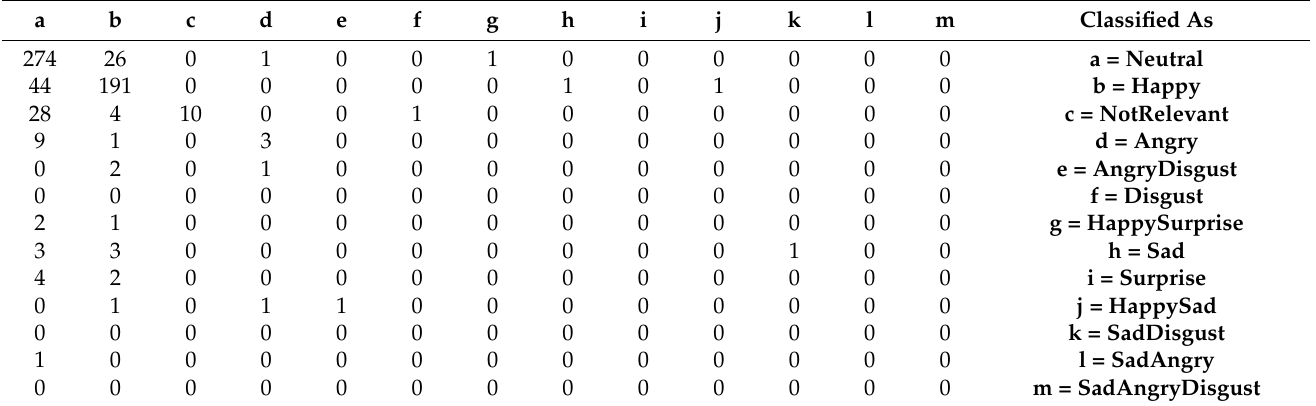
Figure 9. Graphical representation of detailed accuracy by class (tetrad feature selection techniques). Table 9 represents the confusion matrix using the tetrad of feature selection technique in combination with LL, and its graphical representation is shown in Figure 10. Table 9. Confusion matrix (tetrad configuration).